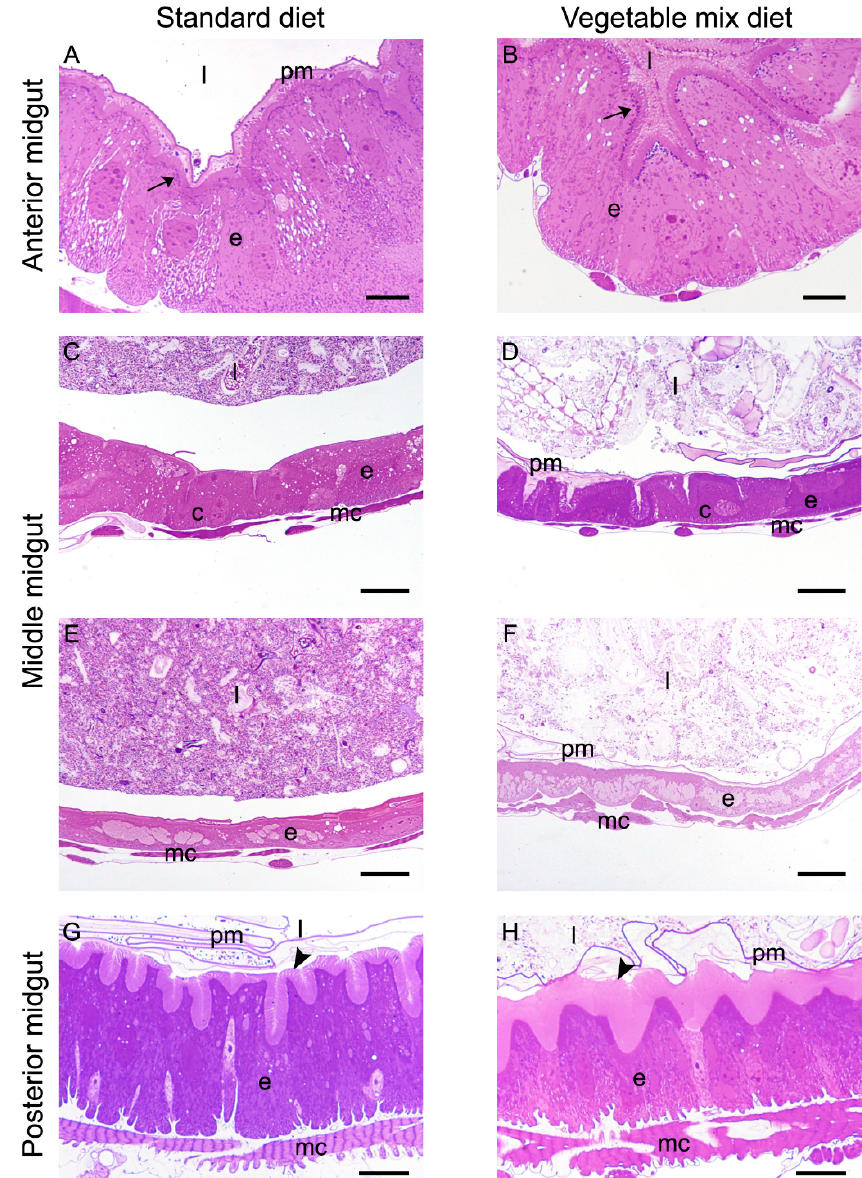
Figure 3. Morphological comparison of midgut from larvae reared on SD and VMD. ( A , B ): cross-sections of the anterior midgut. ( C – F ): copper ( C , D ) and large flat cells ( E , F ) in the middle midgut of H. illucens larvae. ( G , H ): cross-sections of the posterior midgut. Columnar cells of larvae grown on VMD ( H ) show microvilli (arrowheads) that are longer than those of columnar cells of larvae reared on SD ( G ). Arrows: dark vesicles under the brush border. c: copper cells; e: epithelium; l: lumen; mc: muscle cells; pm: peritrophic matrix. Bars: 10 µ m ( A , B ), 20 µ m ( C – H ).